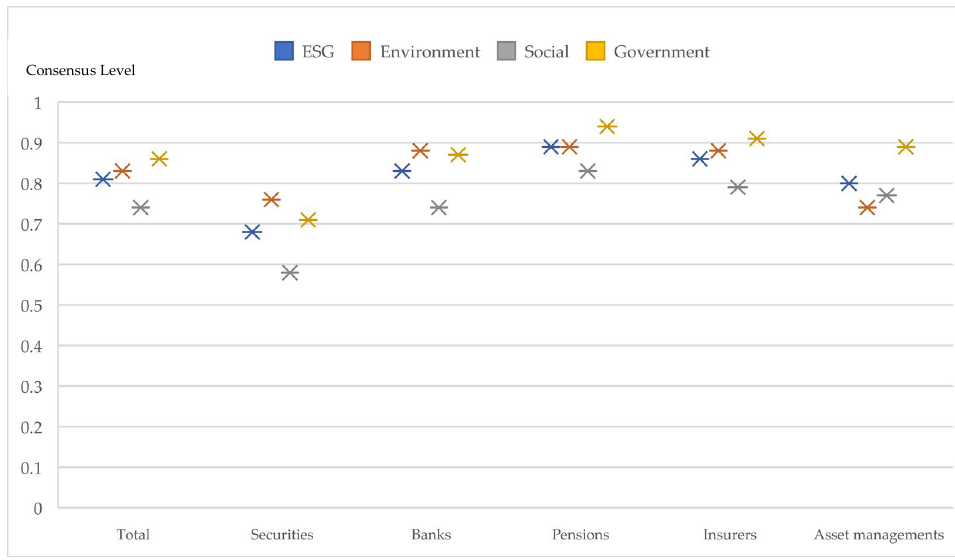
Figure 10 . Consensus measure. Figure 10. Consensus